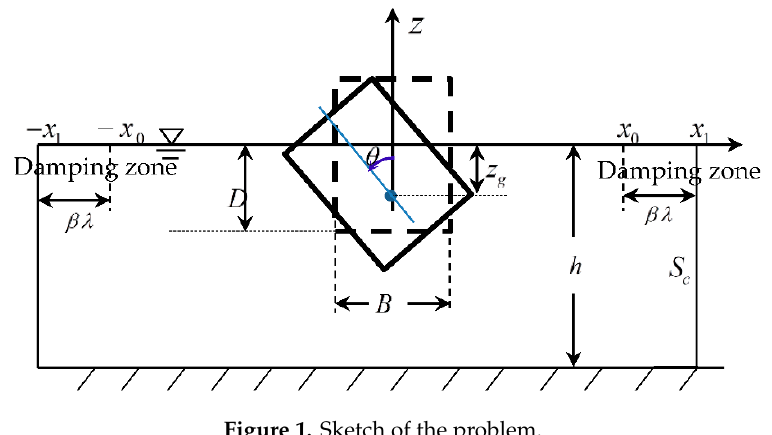
Figure 1. Sketch of the problem.